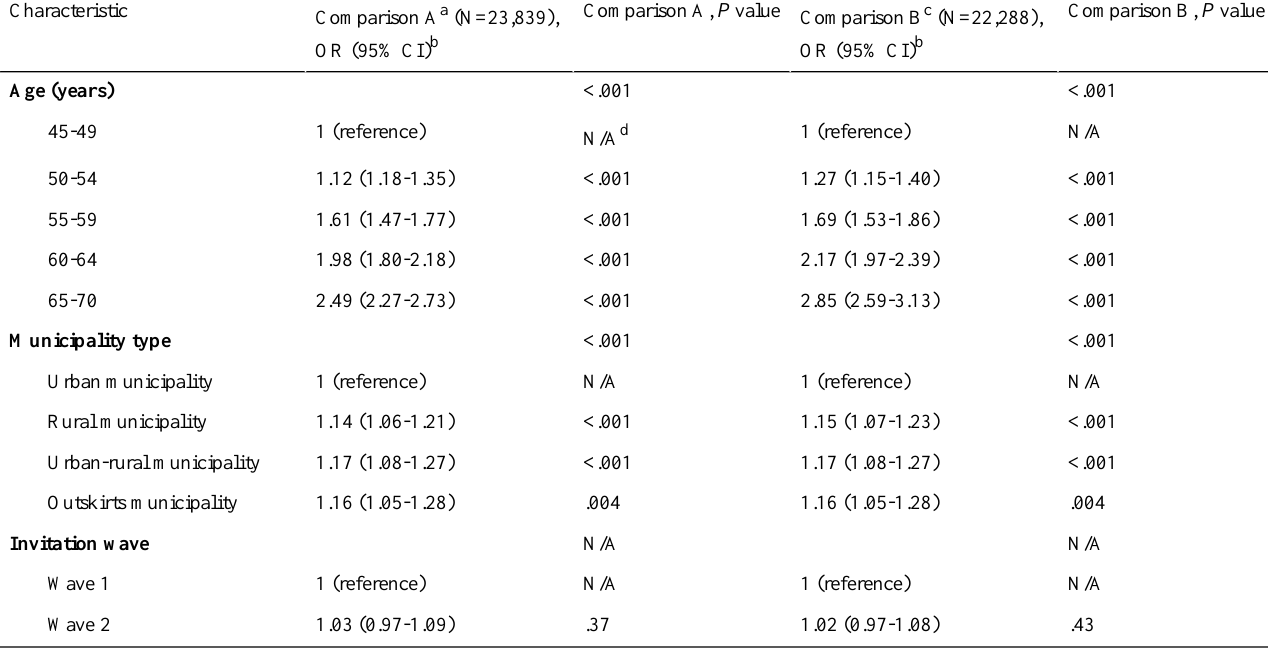
Table 2. Comparison of responders and nonresponders according to age and dwelling.